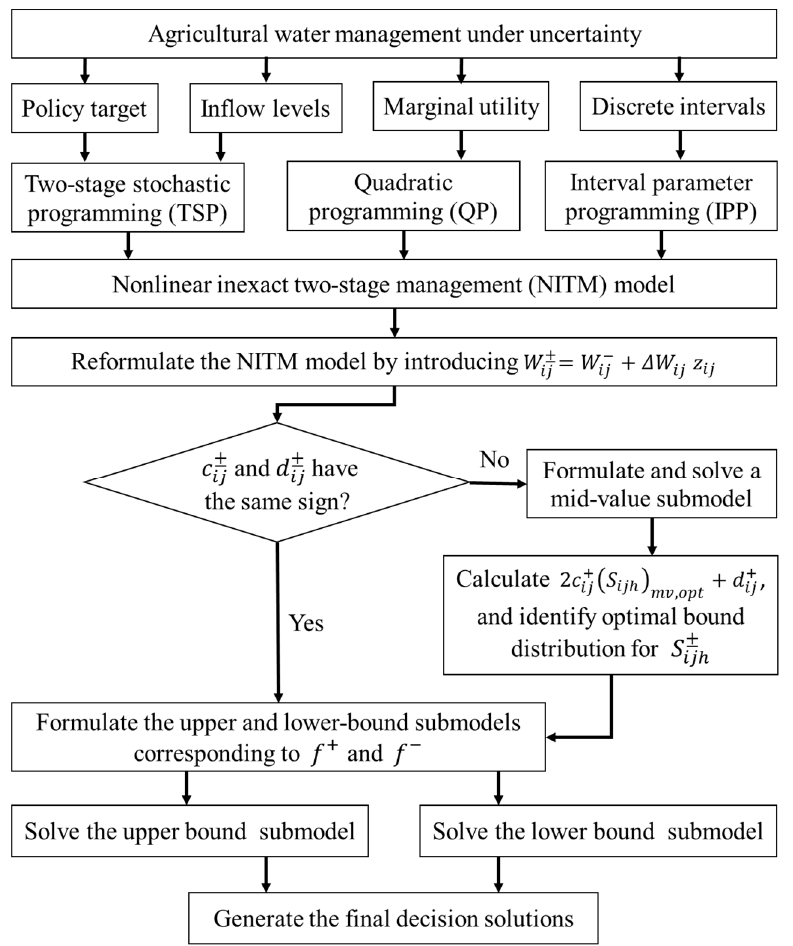
Figure 1. The framework of the NITM model. Table 1. Notation of the decision variables and input parameters.